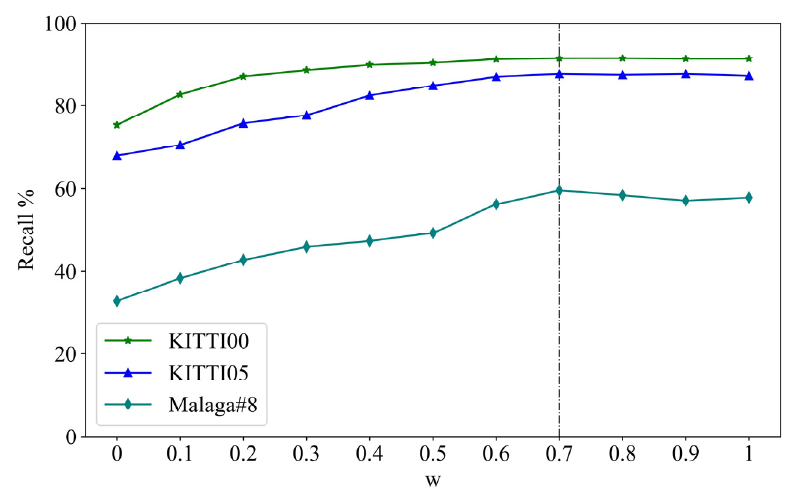
Figure 6. Effect of weighted fusion on KITTI00, KITTI05, Malaga#8 datasets.